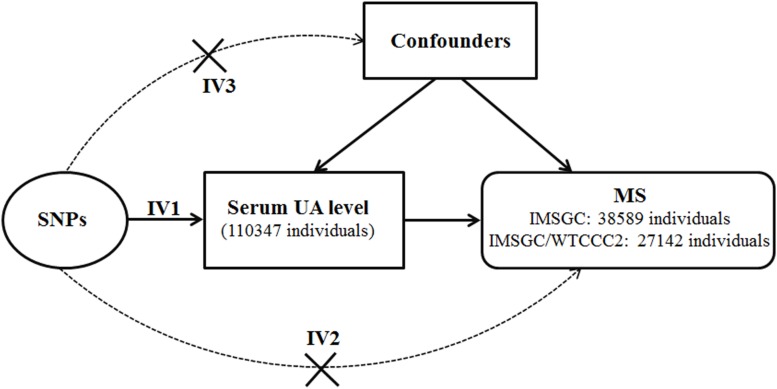
Diagram of Mendelian randomization analysis of serum uric acid level and multiple sclerosis. Abbreviations: MS = multiple sclerosis; SNP = single-nucleotide polymorphism; UA = uric acid. The three assumptions of the Mendelian randomization study are as follows: the SNPs associate with serum uric acid level (assumption IV1); the SNPs do not affect multiple sclerosis by other pathways (assumption IV2); and the SNPs are not associated with confounders (assumption IV3).